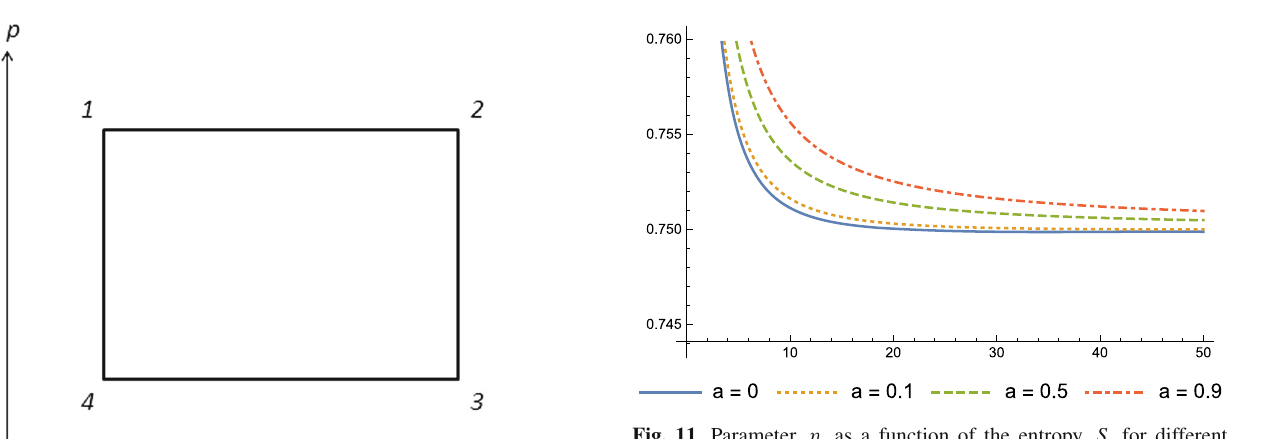
Fig. 11 Parameter, η , as a function of the entropy, S , for different values of a Q H